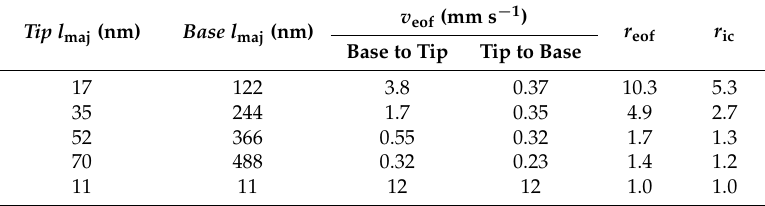
Figure 10. Fluxes of phenol from tip to base and from base to tip measured through a mica membrane containing pyramidal pores with tip and base lengths, Tip and Base l maj , of 17 and 122 nm, respectively. The feed solution initially contained 10 mM phosphate buffer (pH 7.0) and 10 mM phenol, and the permeate solution initially contained 10 mM phosphate buffer (pH 7.0). Reproduced with permission from [31]. American Chemical Society, 2010.